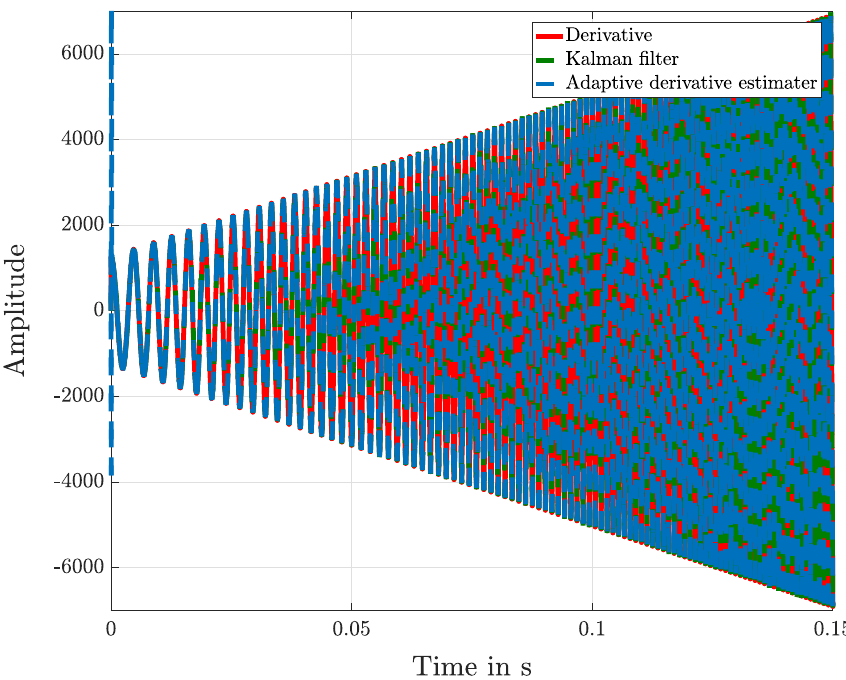
Figure 10. Graphical representation of chirp input signal with a starting frequency of 200 Hz.